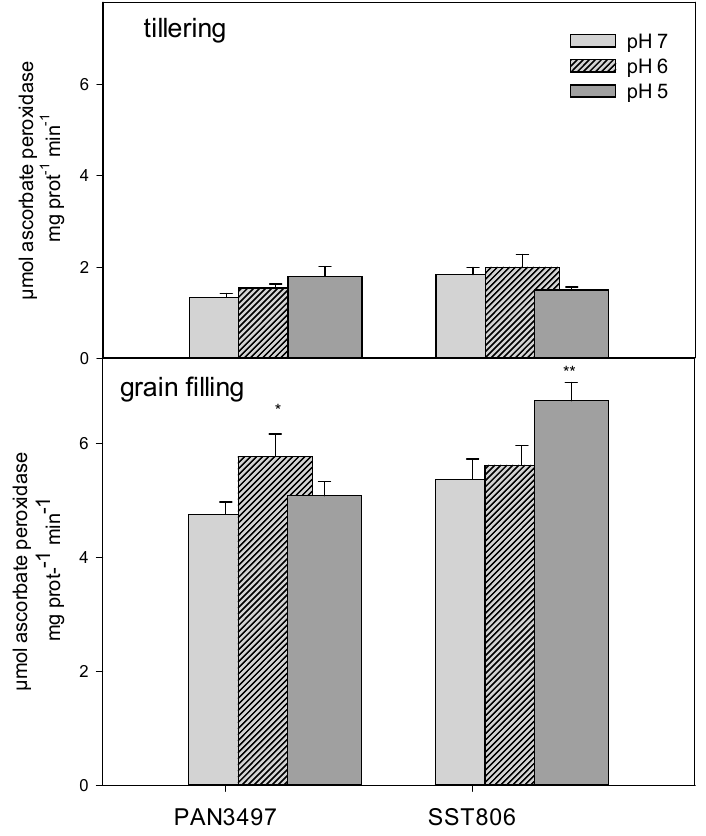
Figure 2. The APX activity of PAN3497 and SST806 grown at three soil pH levels (pH 7, 6, and 5), with two sampling times (tillering and grain filling). Values are the averages of three biological and technical repetitions ± SE. Significant difference compared to pH 7: * p < 0.05, ** p < 0.01. Higher tetraguaiacol content (representing high peroxidase activity) was measured during grain filling than tillering (Figure 3). Peroxidase activity for PAN3794 showed no significant changes for either growth stage. Contrary to this, a highly significant reduction in peroxidase activity was observed for SST806 at pH 5 during tillering. However, at grain filling, activity was significantly higher at pH 5.